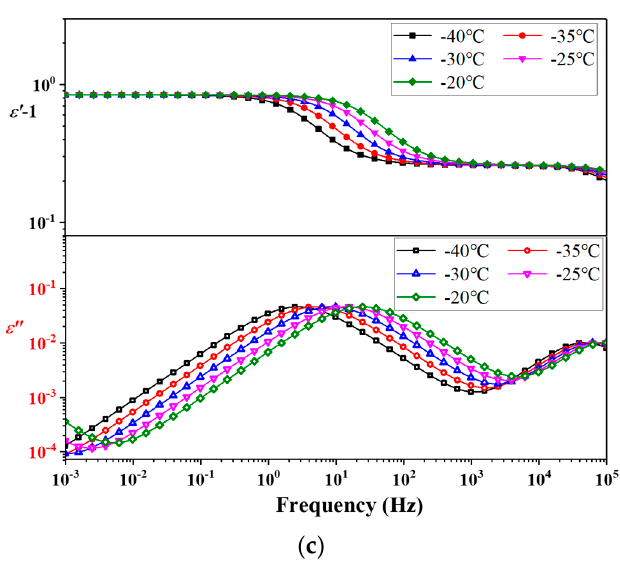
Figure 4. Measured FDS curves for the oil-impregnated cellulose paper sample in different temperature ranges: ( a ) FDS curves tested in the high-temperature range; ( b ) FDS curves tested in the middle-temperature range; ( c ) FDS curves tested in the low-temperature range.